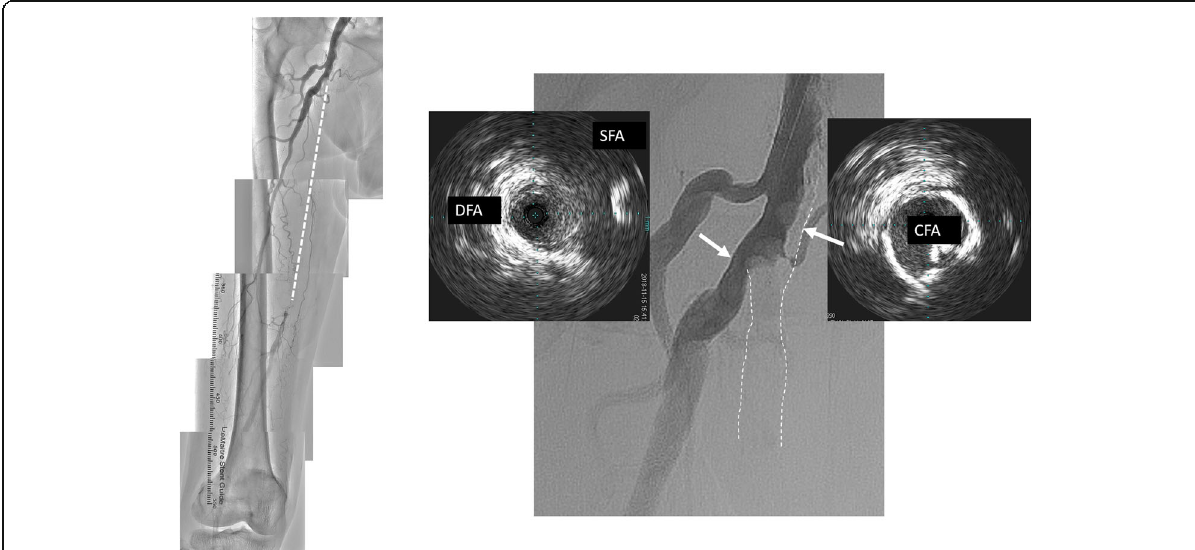
Fig. 1 Angiography revealed a total occlusion in the right SFA. IVUS from the DFA revealed that the calcified plaque at the ostium of the SFA protruded into the CFA. SFA, superficial femoral artery; IVUS, Intravascular ultrasound; DFA, deep femoral artery; CFA, common femoral